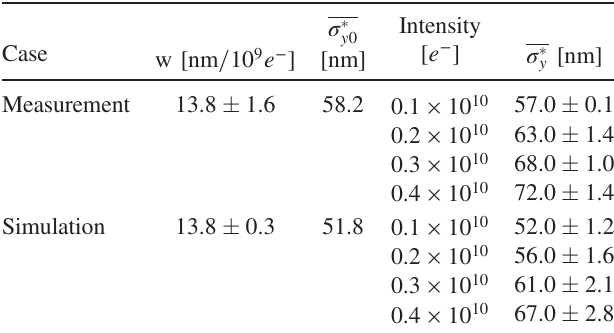
TABLE VI. Comparison between measurements and simula- tions of the average vertical beam size at the IP ( σ (cid:1) y ) vs the beam intensity and the fitted parameters of Eq. (1).